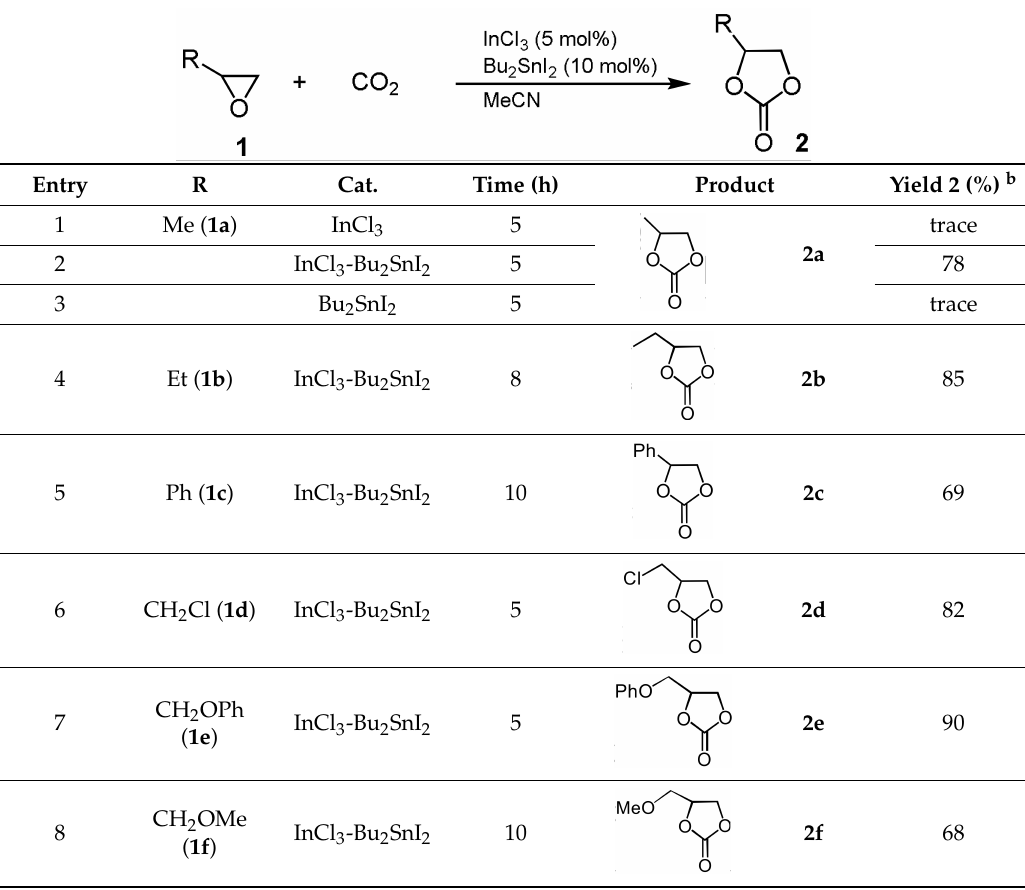
Table 1. Synthesis of cyclic carbonates 2 from epoxides 1 with CO 2 at rt a